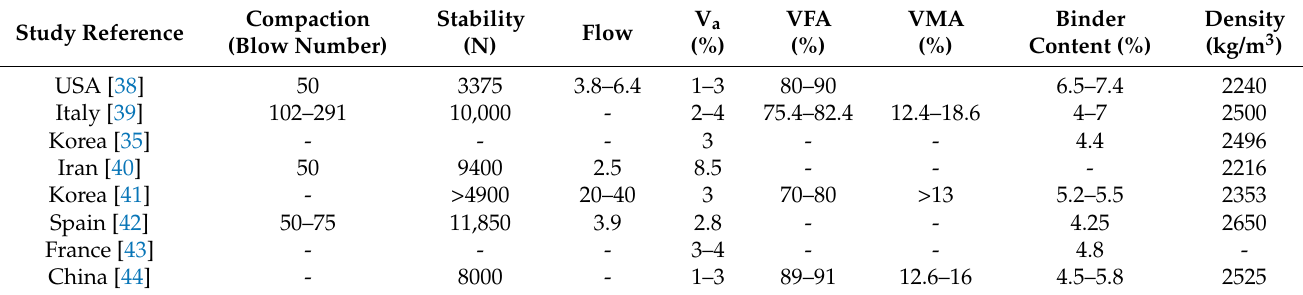
Table 5. Recommended properties of asphalt for